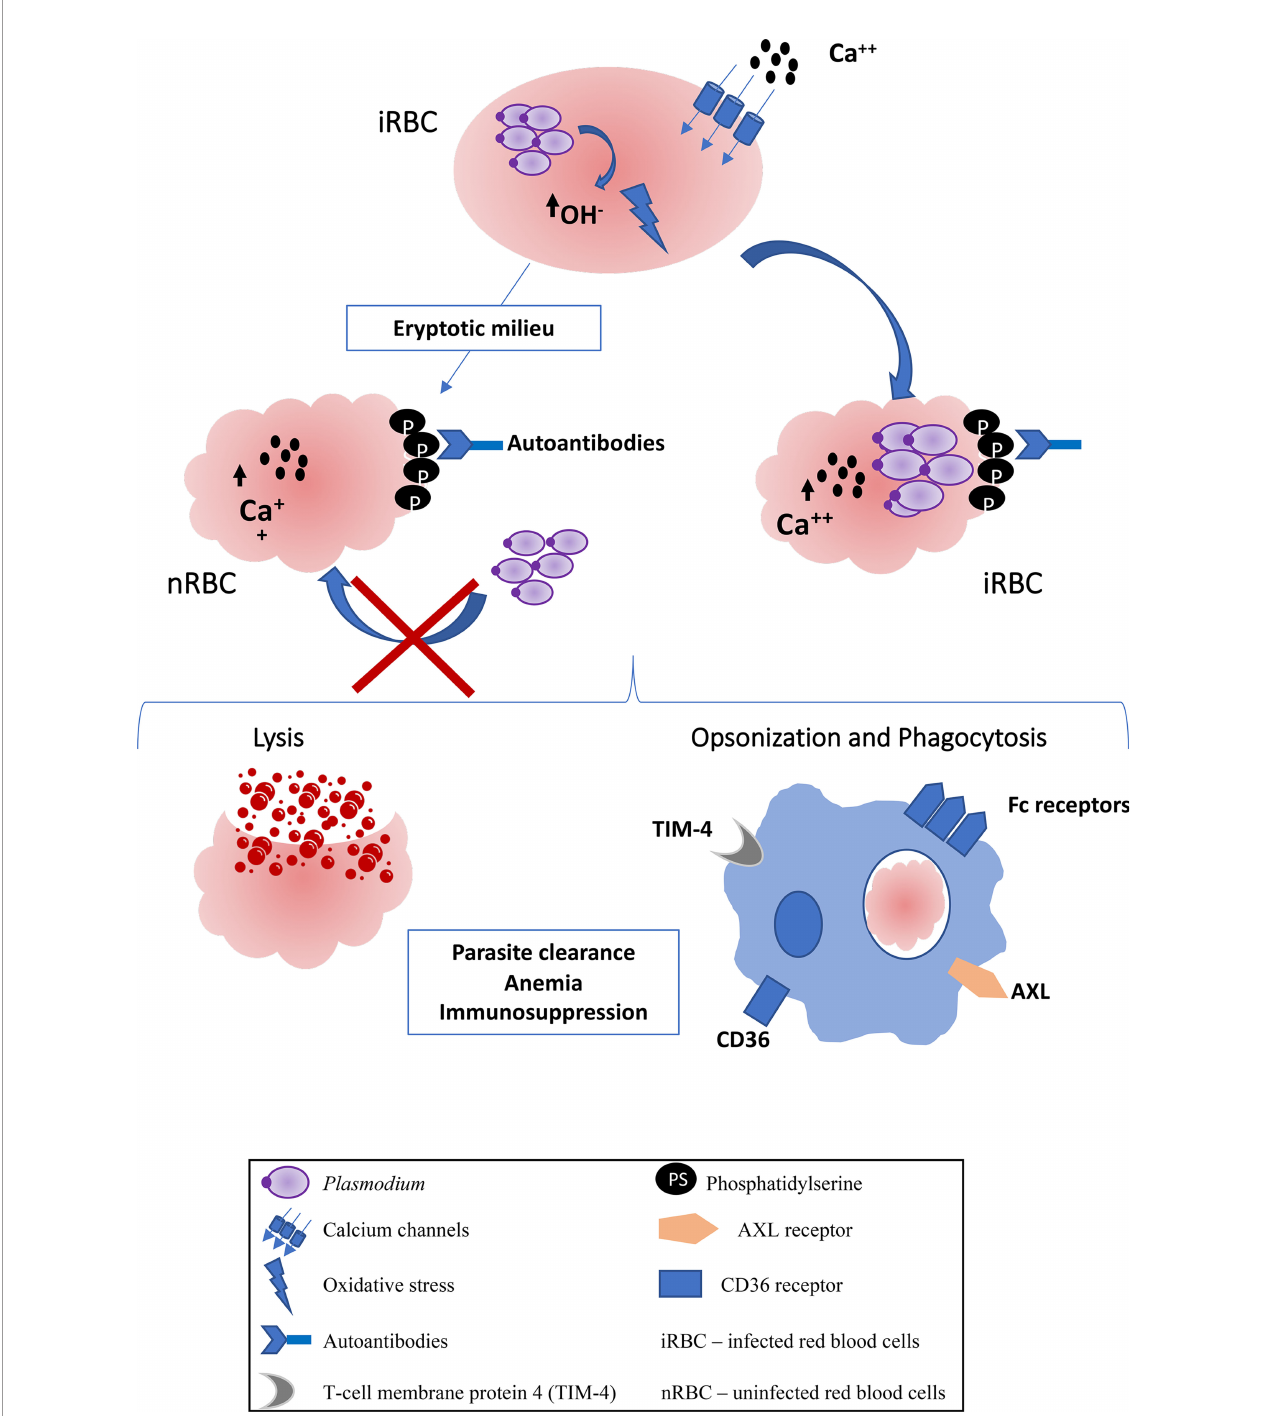
FIGURE 1 | Scheme of eryptosis in Plasmodium infection. The metabolism of the parasite induces the production of OH-radicals that promote oxidative stress in red blood cells. There is the opening of calcium channels, an increase in intracellular calcium and, consequently, the exposure of phosphatidylserine. Uninfected red blood cells also suffer eryptosis, probably from eryptotic factors released by infected red blood cells, becoming refractory to infection. Both uninfected and infected RBCs are eliminated by lysis mediated by activation of the complement system, or by prophagocytosis mediated by Fc receptors on phagocytes, due to the presence of autoantibodies against phosphatidylserine. There are also speci fi c receptors against phosphatidylserine that can promote uptake by phagocytes, such as CD36, TIM-4 and AXL. The consequences of eryptosis can be, parasite clearence, anemia and